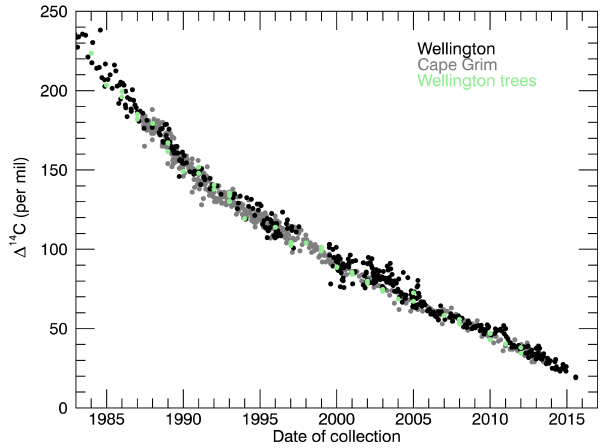
Figure 3. Comparison of the final Wellington and Cape Grim (Levin et al., 2010) (cid:49) 14 CO 2 records. Wellington tree ring measurements are also